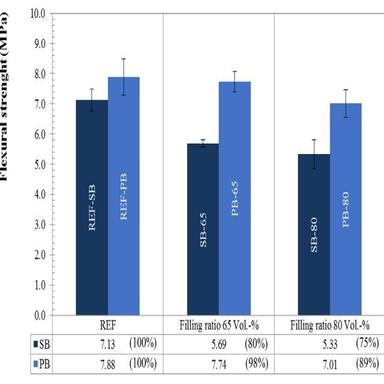
Comparing the flexural strengths, Rf, between PCM-RBA mortar mixtures with SB and PB RBAs. The vertical scatter indicators represent the range between the minimum and the maximum values.